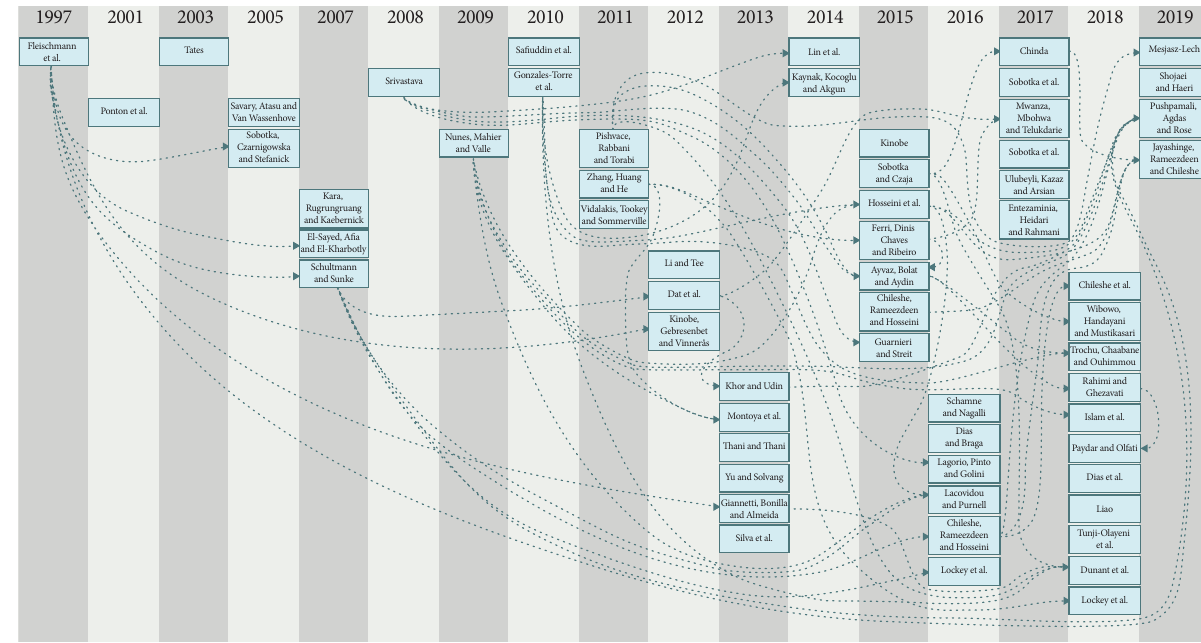
Figure 3: Citations among the reviewed